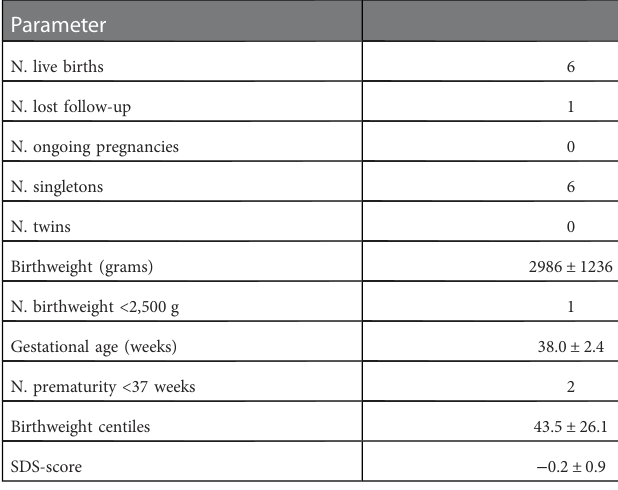
TABLE 4 Neonatal characteristics of live births in post COVID-19